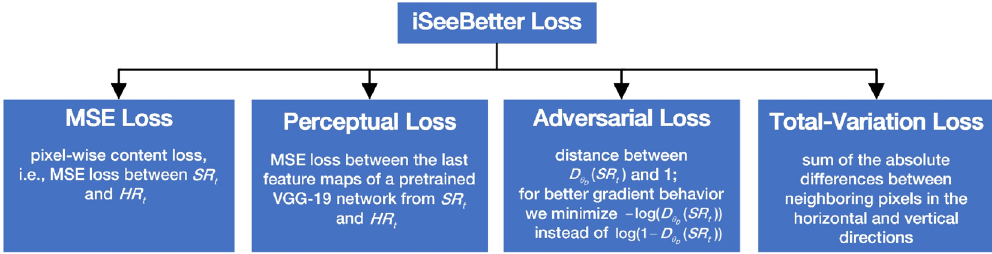
Fig. 6 MSE, perceptual, adversarial, and TV loss components of the iSeeBetter loss